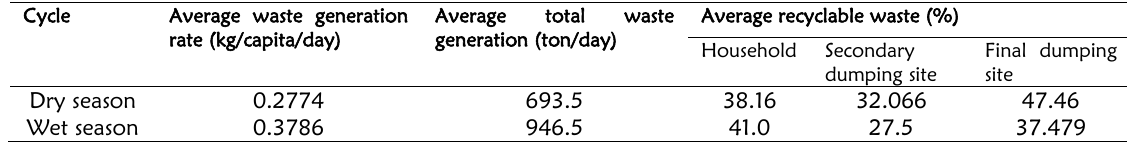
Table 6: Recyclable waste composition of Gazipur city [24]